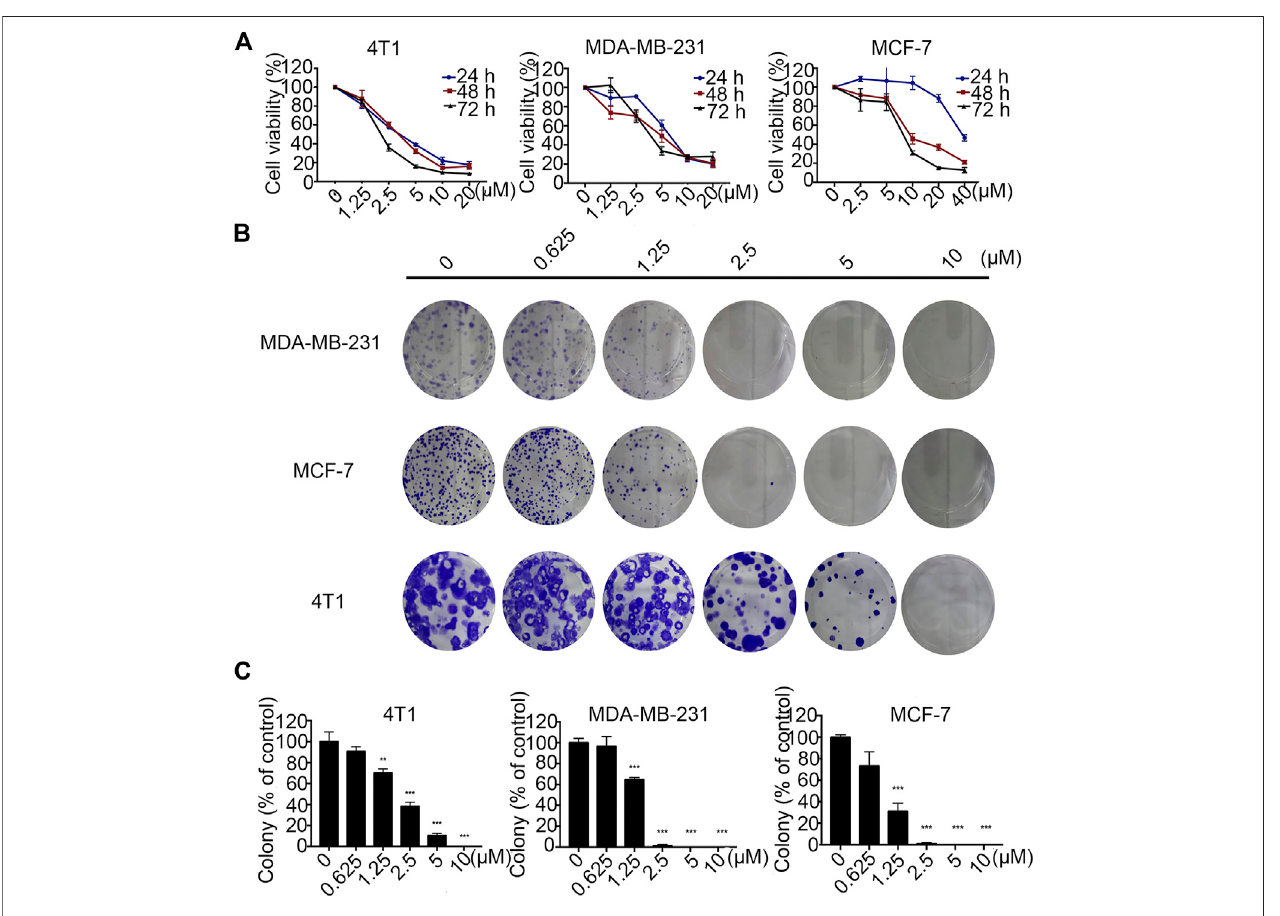
FIGURE 3 | Statmp-151 inhibited the growth of breast cancer cells in vitro. (A) Breast cancer cell lines 4T1, MDA-MB-231 and MCF-7 were treated with different concentrations of Statmp-151 for 24, 48 and 72 h, respectively. (B) The effects of statmp-151 on the colony formation in three breast cancer cell lines for 10 days. (C) The statistical results were presented using vehicle control at 100%. Each point represents the mean ± SD for at least 3 independent experiments (* p < 0.05, ** p < 0.01 and *** p < 0.001 vs. control group).